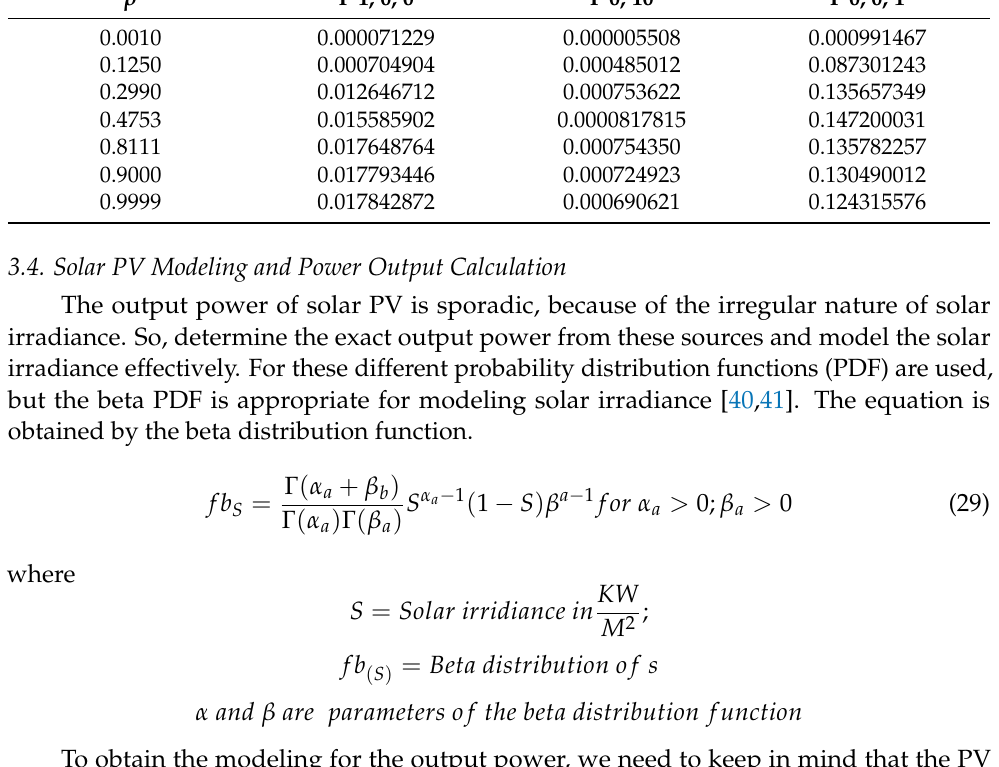
Table 3. Results for third scenario (solar, wind and gas turbine) in D.S. type three. ρ P 1, 0,